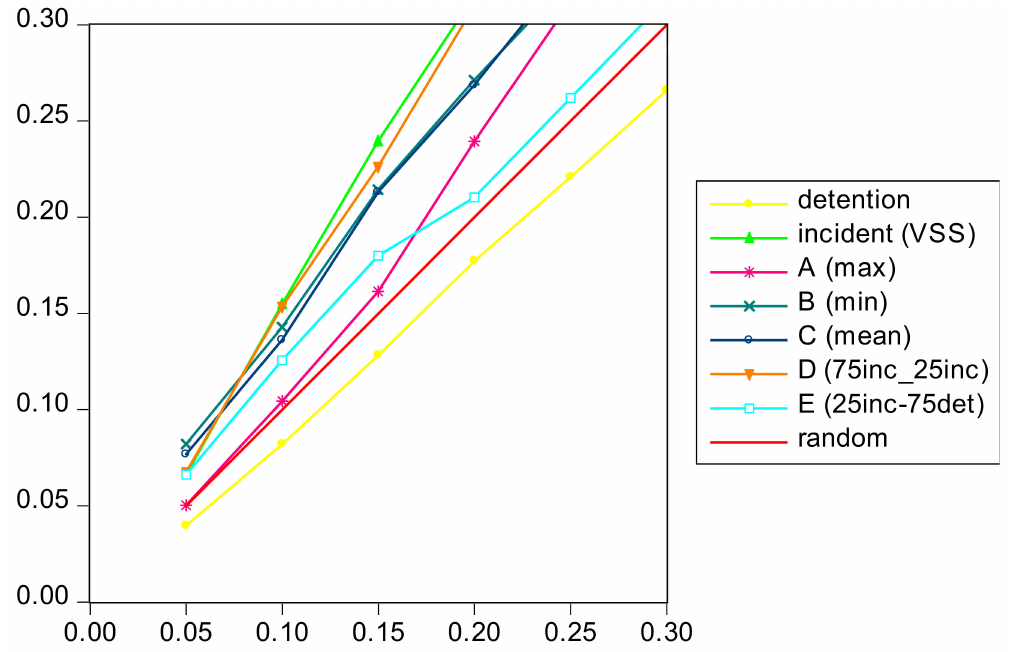
Figure 1. Receiver operating characteristic (ROC) curve top 30%—evaluation variable incidents (VSS): total incidents